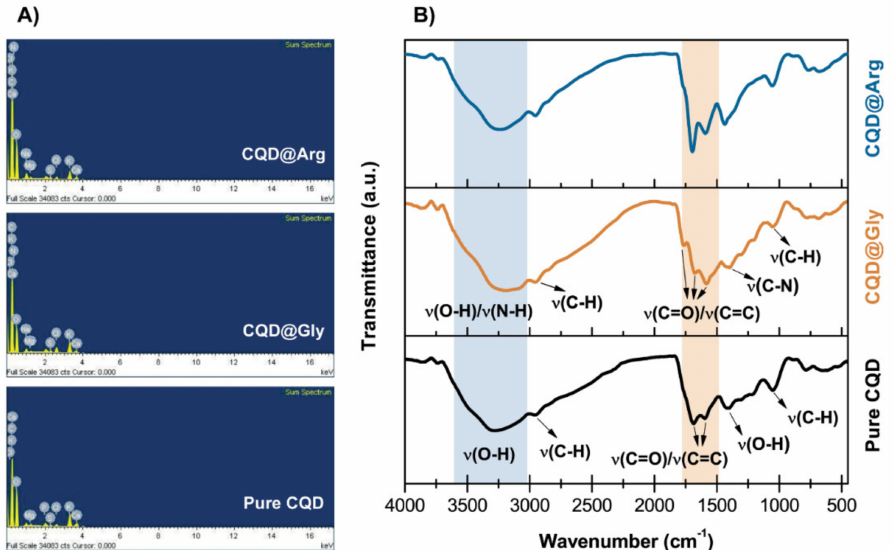
Figure 1. EDS spectrum ( A ) and FTIR spectra ( B ) of prepared CQDs and